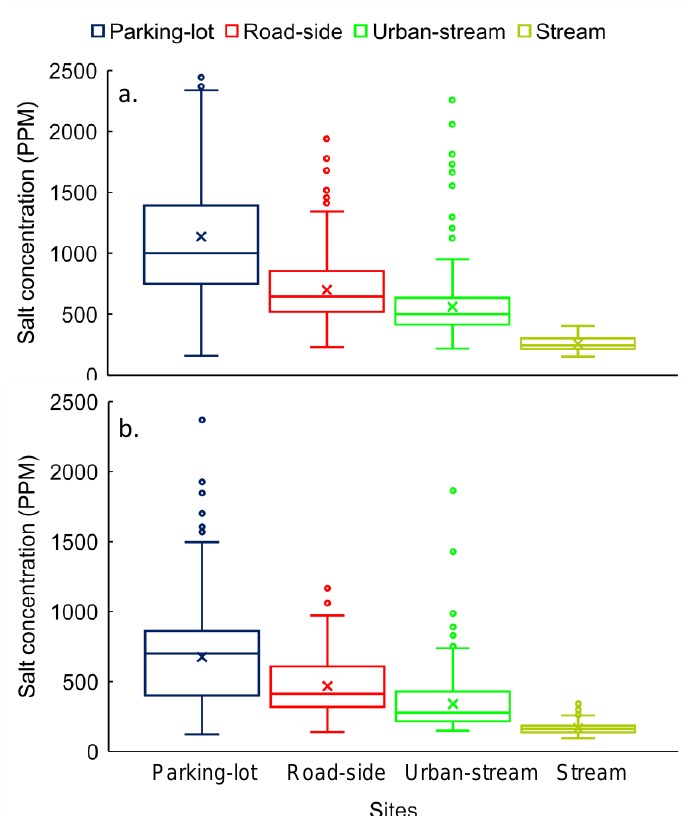
Figure 7. Salt concentrations distribution for overall-site (parking-lot drain, roadside drain, urban- stream, and stream) during ( a ) winter and ( b ) spring seasons. The vertical axis is adjusted to 2500 ppm, therefore outliers (10) ranging from 2500 to 4000 are not visible in the figure. As in the spring, the lowest concentrations were measured at stream in the winter and chronologically increased in urban-stream, roadside drain, and parking-lot in spring (Figure 7b). The concentration variability ranged from 29% to 51%. Based on direct com- parison site by site, concentration variability increased in spring compared to winter at stream, urban-stream, and roadside, except for parking-lot, where it decreased. Similar in the winter, the null hypothesis was rejected ( p < 0.05) for all pair-wise comparisons, which indicated that concentrations were significantly different from one site to another sites (Figure 7b). 3.2. Temporal Variation 3.2.1. Parking-Lot Drain The mean ± standard deviation concentrations for all sensors (S# 2, 3, 14, 17, and 32) varied from 564 ± 646 ppm to 1695 ± 629 ppm at the parking-lot drain in the winter (Figure 3a). Whereas, the mean concentrations for all sensors varied from 342 ± 163 ppm to 863 ± 440 ppm in the spring (Figure 3b). The permutation test rejected ( p < 0.05) the null hypoth- esis for all pair-wise (winter vs. spring) comparisons (individual sensors) for winter and spring. Therefore, there are significant differences (higher in winter) in concentration for all sensors (Figure 3a,b). 3.2.2. Roadside Drain The mean concentrations varied from 616 ± 263 ppm to 827 ± 227 ppm at the roadside drain in winter (S# 8, 11, 27, and 20) (Figure 4a), whereas it varied from 348 ± 147 ppm to